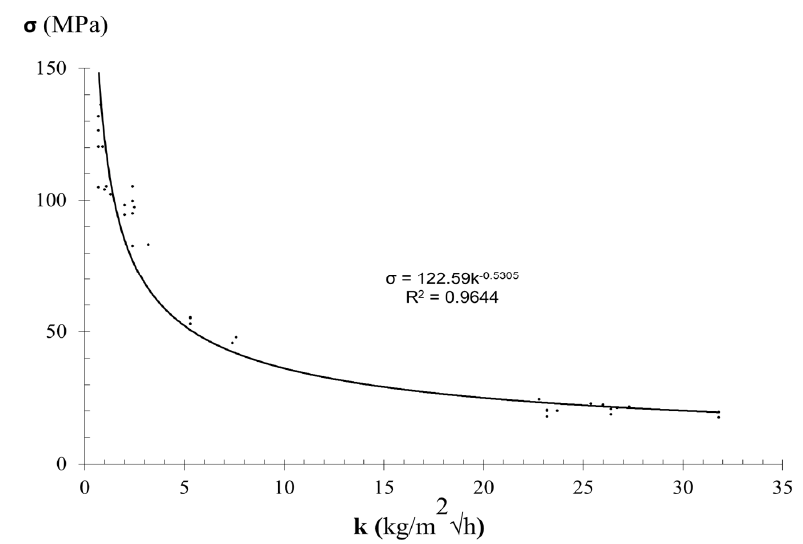
Figure 5. Relationship between compressive strength ( σ c ) and coefficient of water absorption under low pressure (k) obtained from sandstone samples.